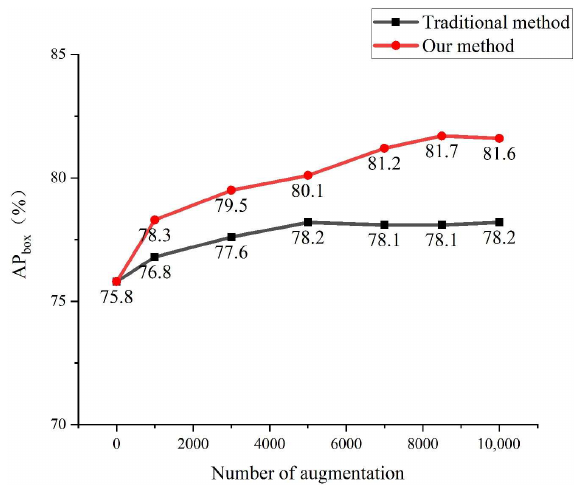
Figure 15. Comparison of AP box .